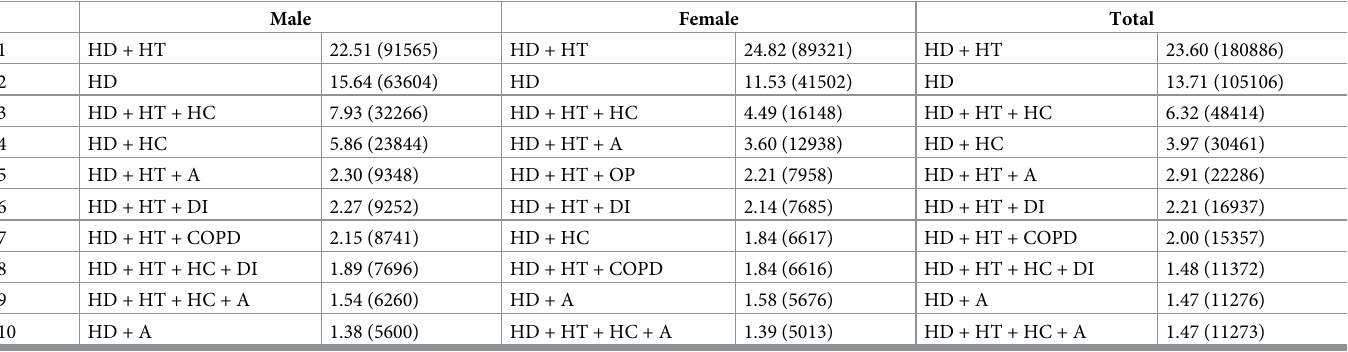
Table 4. Top 10 disease portfolio prevalence at time of HD diagnosis according to sex.